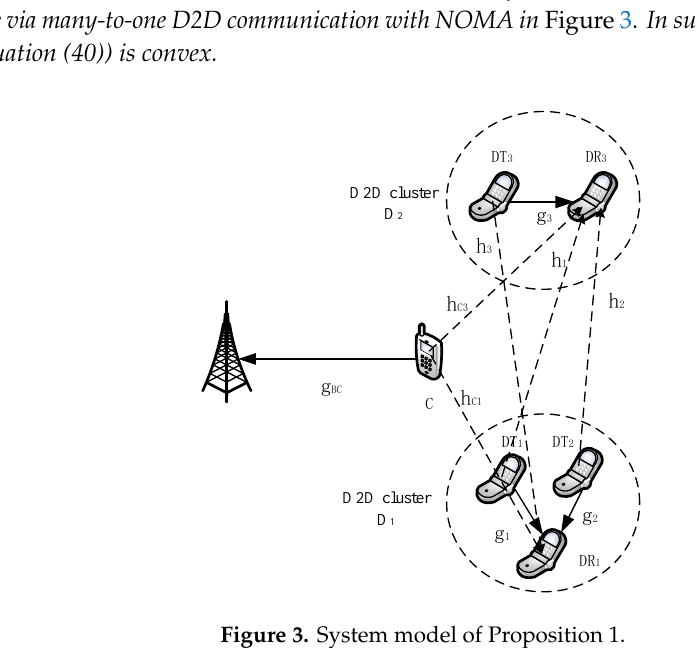
Figure 3. System model of Proposition 1.